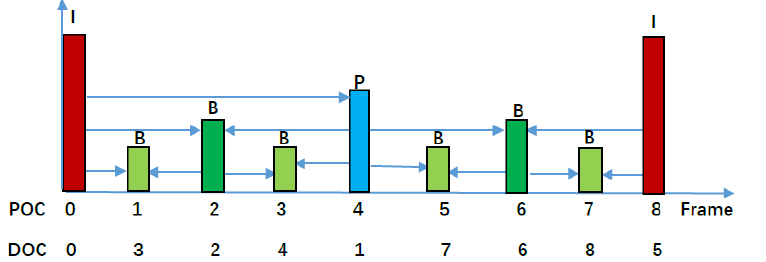
Figure 2. Frame reference relationship of HEVC RA mode. In the figure, frame I is an internal coding frame, frame P is a forward reference frame, and frame B is a bidirectional reference frame.